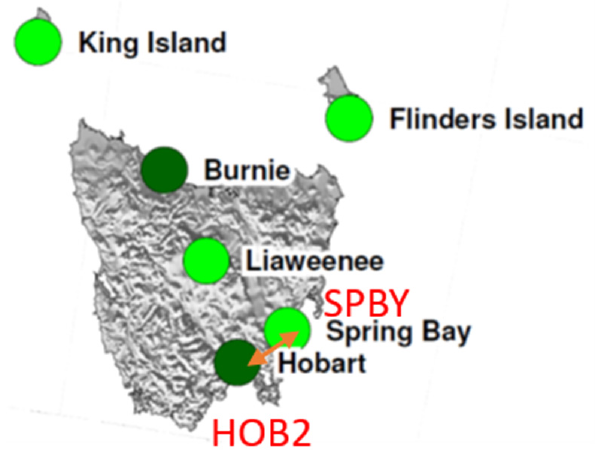
Figure 1. Figure 1. Reference stations of HOB2 and SPBY. (https://www.ga.gov.au/scientific-topics/position- ing-navigation/geodesy/gnss-networks/station-coordinates-and-maps, accessed on 1 October 2021).